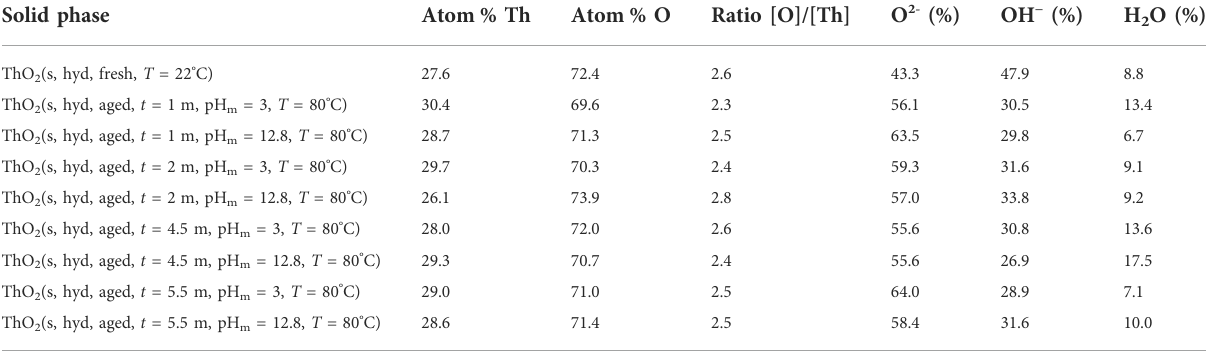
TABLE3 Atomic% ofThandO,ratio[O]/[Th]and speciation ofoxygen (asatomicpercent ofoxide, hydroxide andwater)ascalculatedfromtheTh 4f and O 1s lines in the XPS measurements. Relative error of atomic concentrations is within ± (10 – 20) %. Solid phase